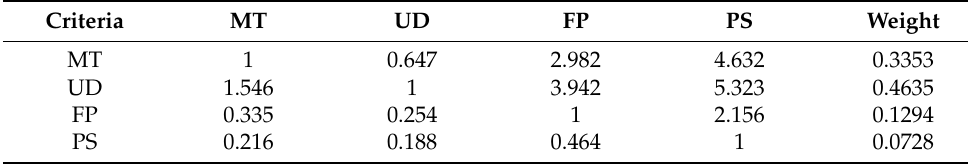
Table 4. Results of the comparison matrix.